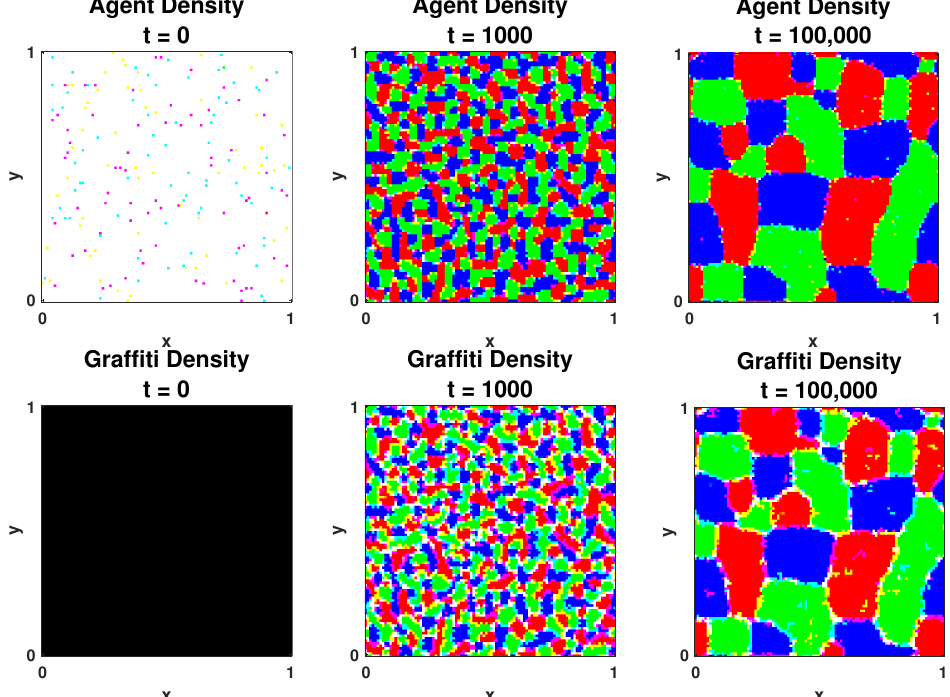
Figure 2. Agent ( top ) and graffiti ( bottom ) densities temporal evolution for a segregated state. Here, we have N 1 = N 2 = N 3 = 50,000, with λ = γ = 0.5, β = 3 × 10 − 5 , δ t = 1 and the lattice size is 100 × 100. We see that the agents segregate into distinct territories, coarsening over